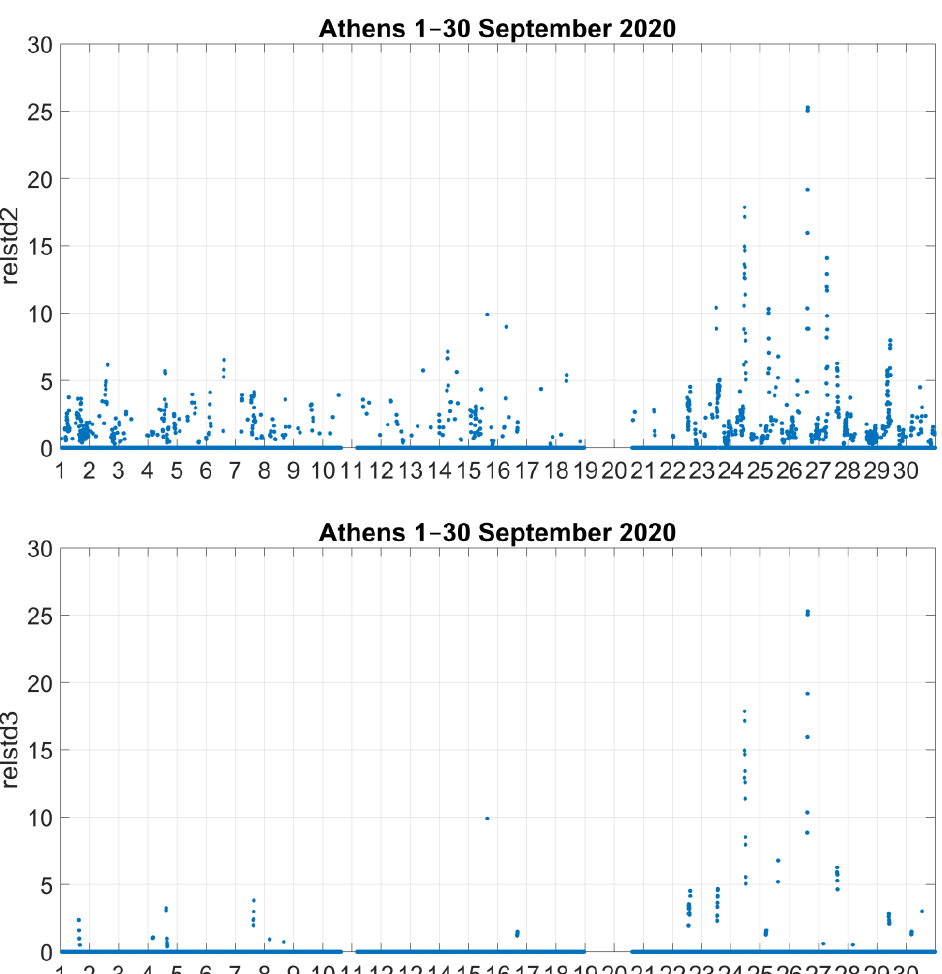
Figure 15. The Dst index (top panel), the ionospheric conditions over Athens in terms of the observed and median foF2 (second panel), and the results derived from the application of LSTID identification criteria (last three panels) for September 2020. In the third panel, the red line at 5 indicates the preliminarily identified threshold for significant LSTID activity (see text for more explanation).